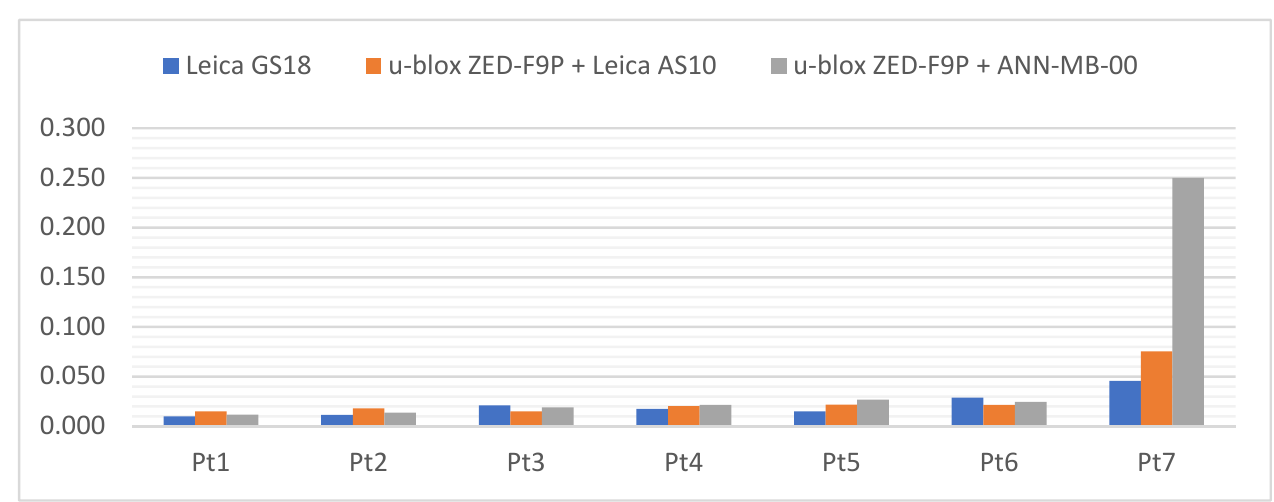
Figure 15. The MSD values [m] on each station point.